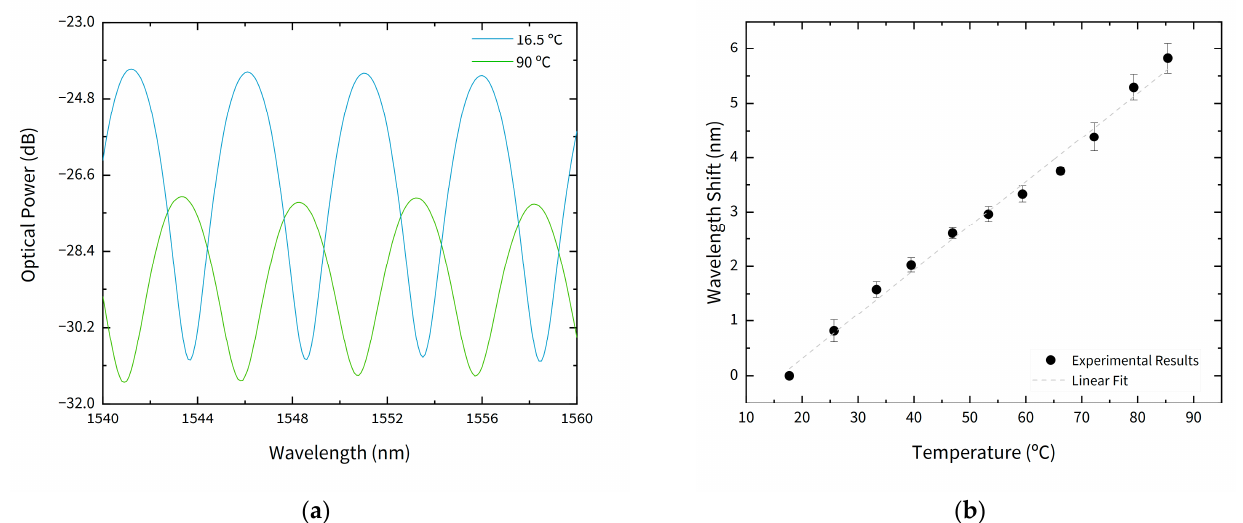
Figure 10. Temperature response of the sensor, for temperatures between 16 °C and 90 °C: ( a ) reflected spectrum for 16.5 °C and 90 °C; ( b ) wavelength shift with temperature.